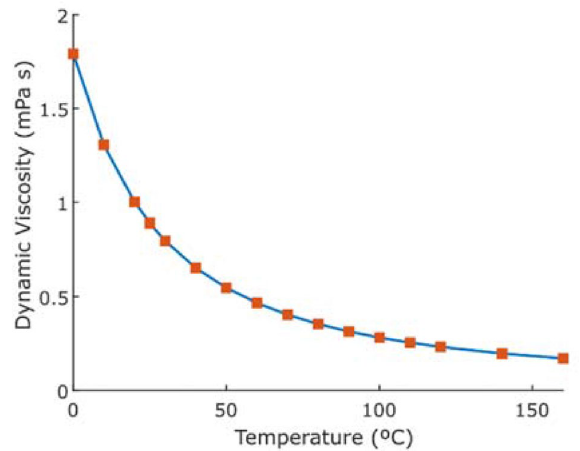
Figure 1. Temperature dependence of viscosity for saturated water 25